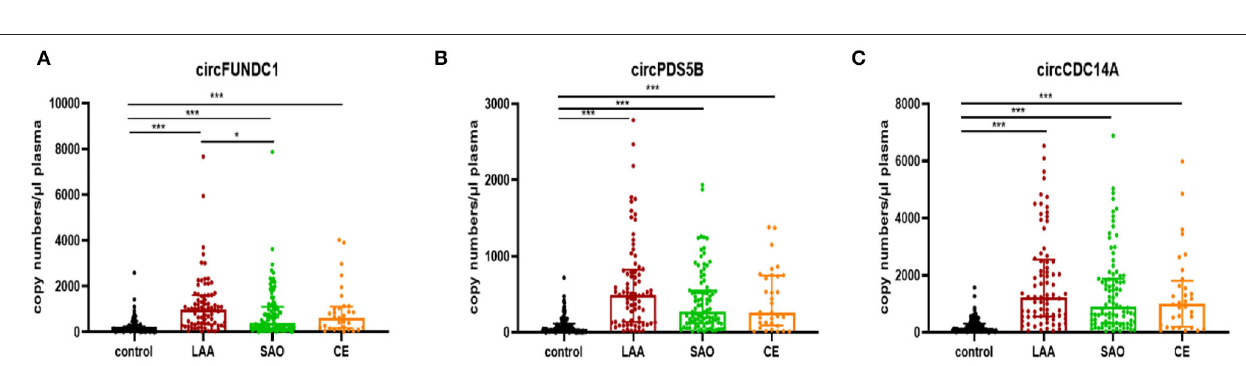
reverse: TCGCATGGATACAATGAATGGC; and circCDC14A, forward: CCATTCTCGACTGTTTGCAGG, reverse: